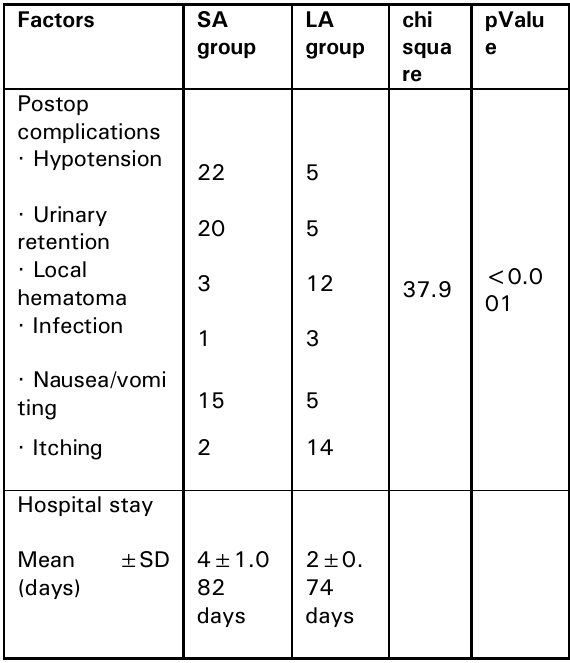
TABLE 5: Intraoperative pain (VAS score) and TABLE 6: Early post op complications and side